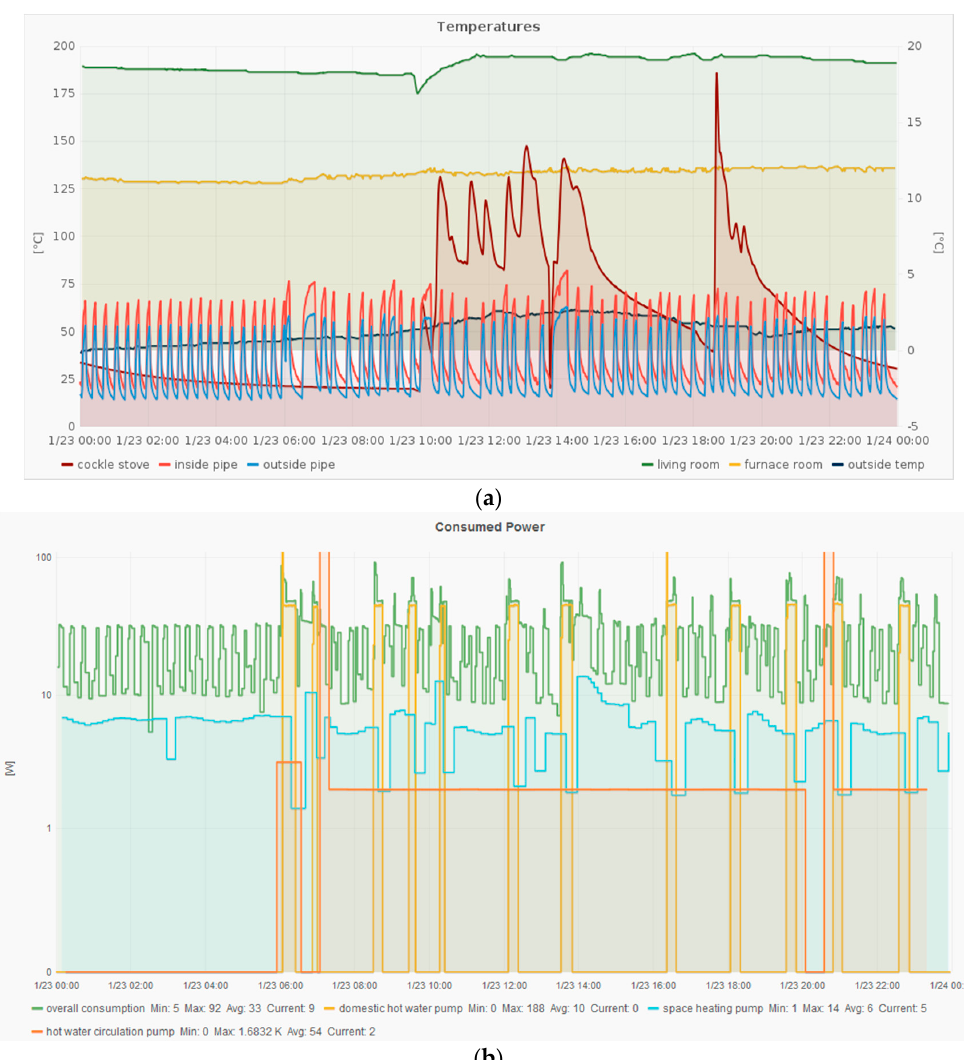
Figure 2. Measurement in a private house: ( a ) Measured temperatures at the heating and the cockle stove; ( b ) Power consumptions of the pumps in the heating.